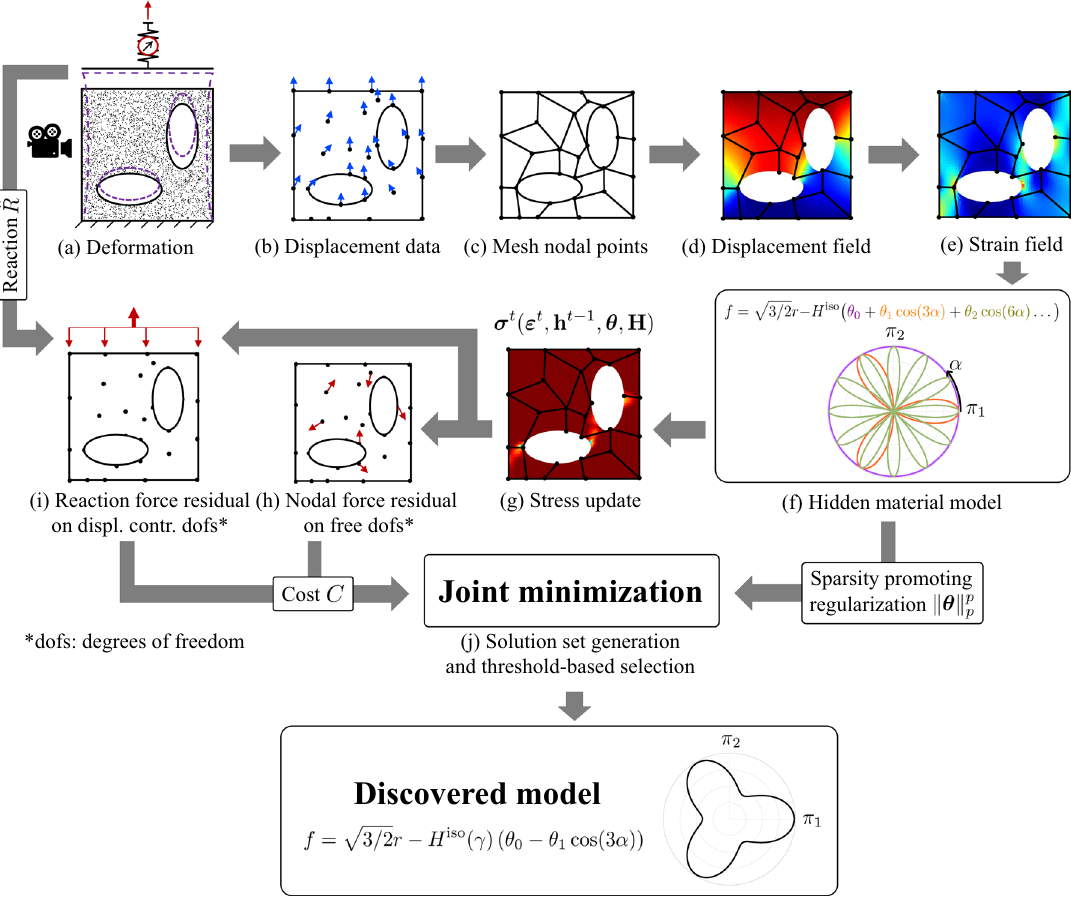
Fig. 1 Step-by-step schematic of EUCLID. In a single experiment with complex geometry ( a ), point-wise displacements ( b ), and global reaction forces ( i ) are measured. A quadrilateral fi nite element mesh is constructed ( c ) to interpolate the displacement data. The resulting displacement fi eld ( d ) is differentiated to arrive at the strain fi eld ( e ). The material model library ( f ) is constructed (here based on a Fourier ansatz). Based on this library and for given material parameters θ and H , the stresses can be calculated by applying a classical elastic predictor- plastic corrector return mapping algorithm at each load step in the data set, while the history variables are updated at each step ( g ). Based on the stresses, the internal and external virtual works and hence the internal ( h ) and external ( i ) force imbalances are calculated, contributing to the cost function C . Finally, the cost function is minimized jointly with a sparsity promoting regularization term ( j ) to generate a set of solutions out of which a solution with low cost and high parsimony is automatically selected. Details are provided in Supplementary Figure